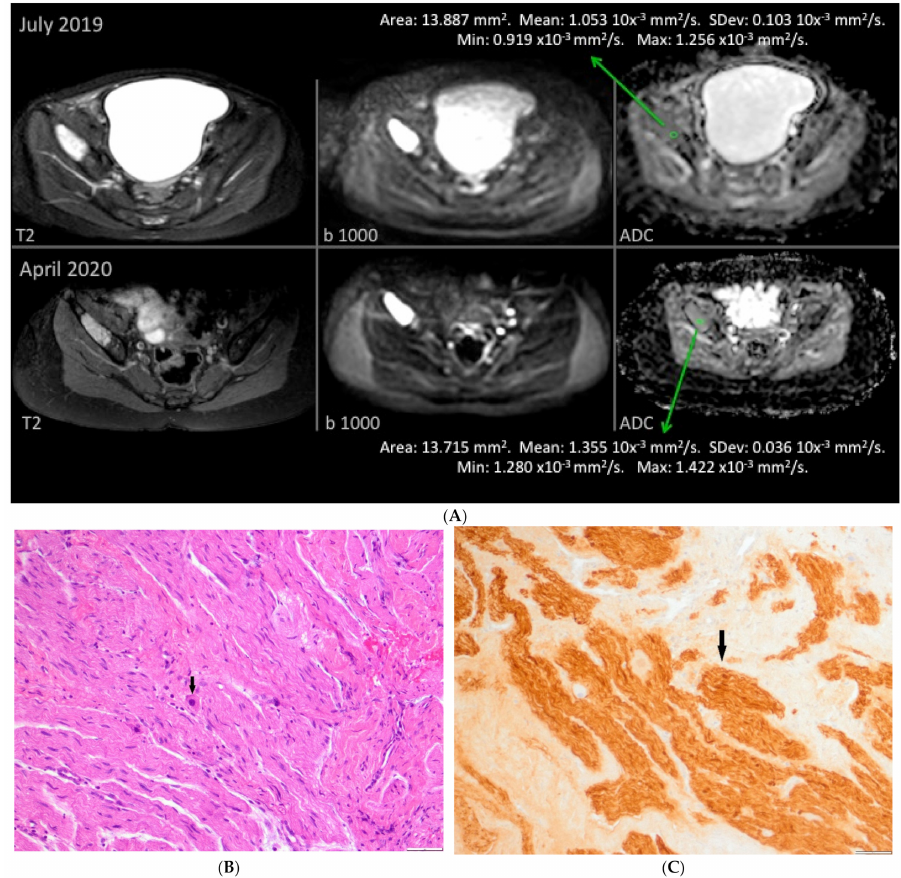
Figure 4. Correlation of functional imaging for patient #1 (Table 1) and histopathology. ( A ) Correlation between pre- immunotherapy treatment (top panels) functional imaging of chemo refractory iliac bone lesion and post immunotherapy evaluation (bottom panels: STIR T2 hyperintense focal iliac bone lesion with restricted diffusion -b 1000- and high- > 1.01- ADC values) of the same iliac lesion. ( B ) Bone tumor from patient #1 post immunotherapy. This sample shows ganglioneuromatous tissue with Schwannian stroma and some mature ganglion cells (arrow). This sample corresponds to the iliac bone lesion described by functional imaging in ( A ) (bottom panels). ( C ) S100 immunostaining highlighting the Schwannian stroma (arrow) of the same iliac bone